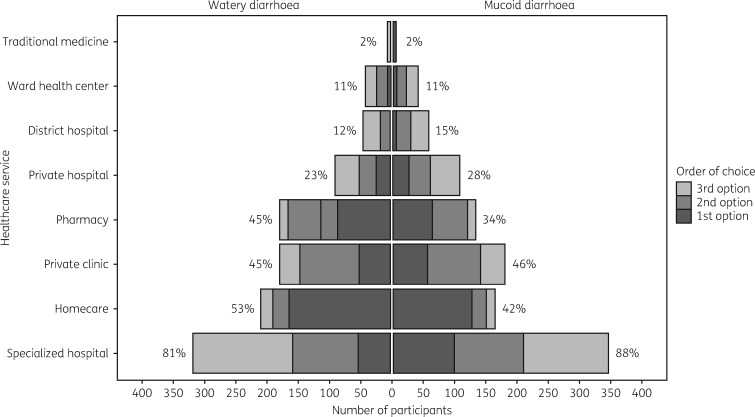
Healthcare utilization for paediatric diarrhoea by caregivers. Pyramid plot showing the number and proportions of 396 individual caregivers or parents of children aged <5 years residing in the study area (x-axis) selecting the various healthcare services (y-axis) as first, second or third choices (see key for shading) for watery and mucoid diarrhoea.